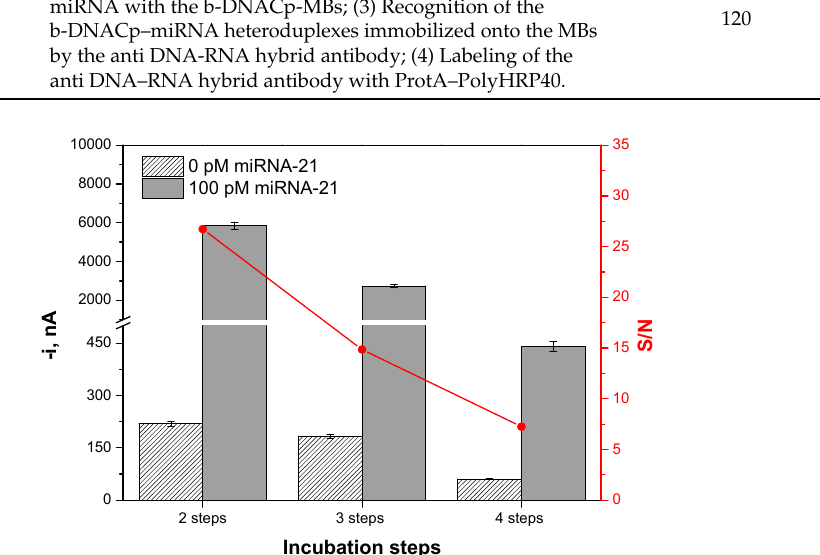
Figure 2. Comparison of the amperometric responses obtained in the absence (N) and in the presence of 100 pM (S) miRNA-21 and the resulting signal-to-noise (S/N) current ratios, when the biosensor was prepared using working protocols with a different number of incubation steps. Error bars estimated at triple of the standard deviation of three